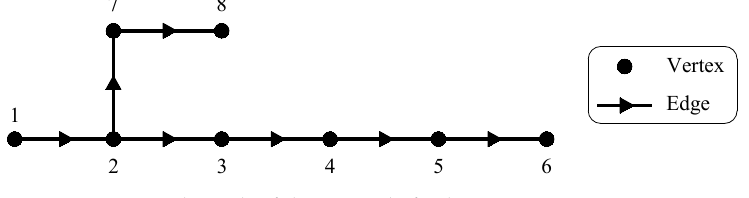
Figure 4. Oriented graph of the example